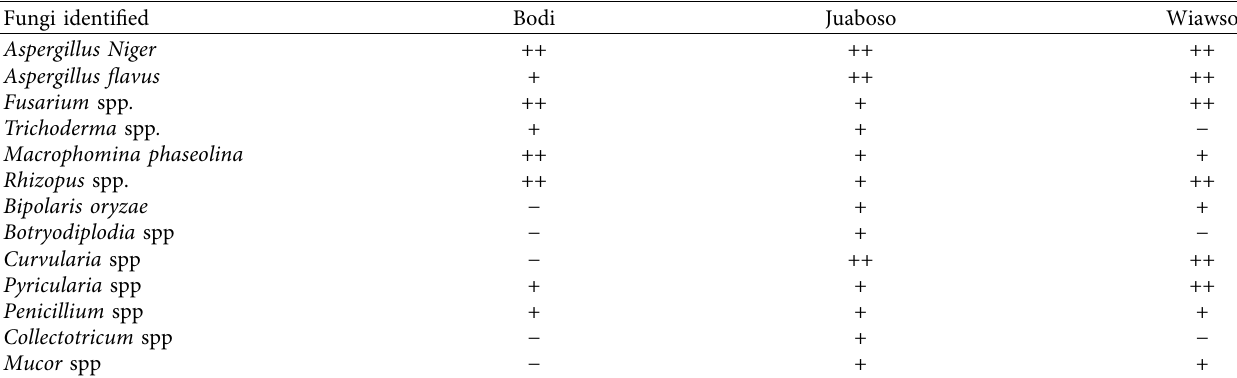
Fungi identifed Blotter Aspergillus Niger Aspergillus favus Fusarium spp. Trichoderma spp. Macrophomina phaseolina Rhizopus spp . Bipolaris oryzae Botryodiplodia spp . Curvularia spp . Pyricularia spp . Penicillium spp . Collectotricum spp . Mucor spp.